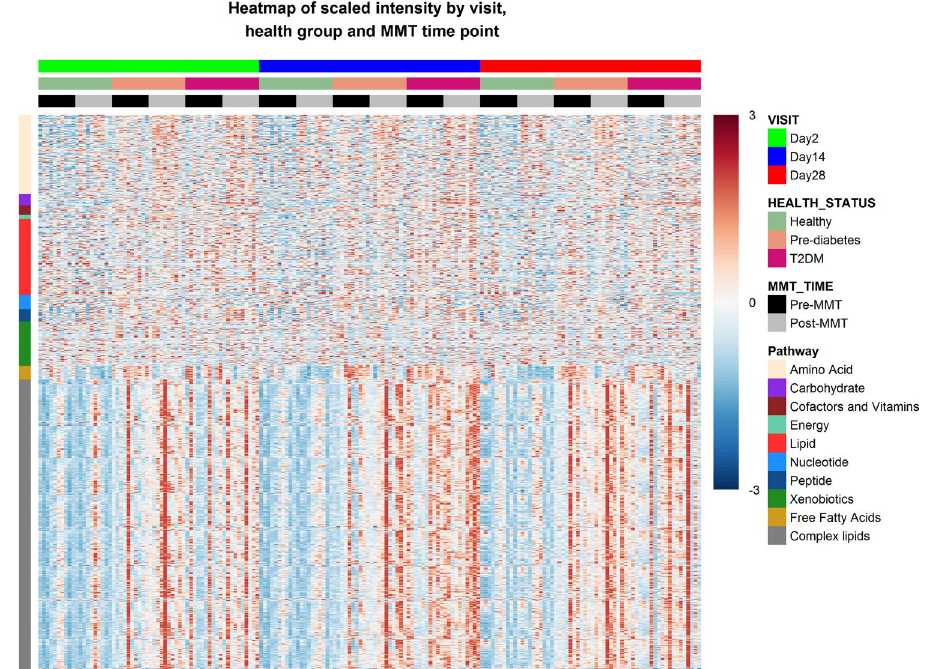
Figure 3. Heat map representing serum metabolite levels for each individual study participant ( horizontal ) ordered by study day, subject category and nutritional status, and individual metabolite ( vertical ) ordered by metabolic